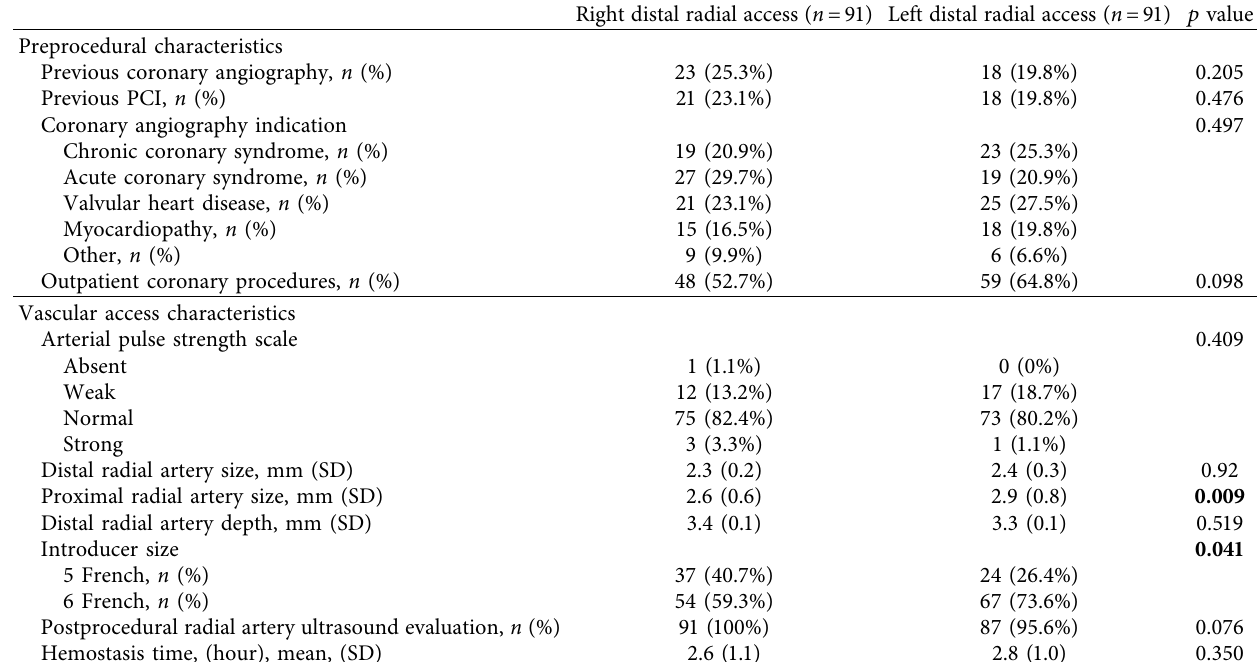
Table 2: Preprocedural characteristics and vascular access